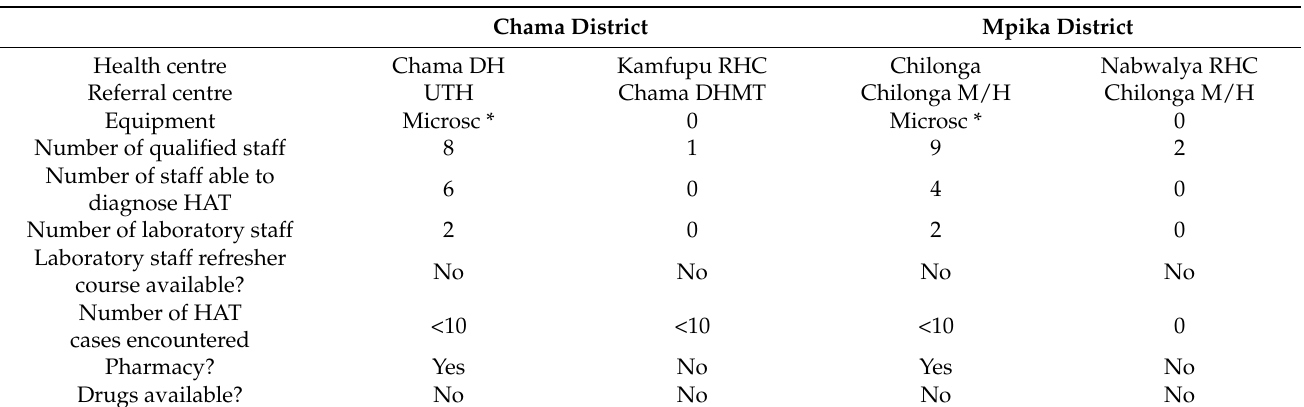
Table 4. Adequacy of the health delivery system for the management of HAT in Chama and Mpika